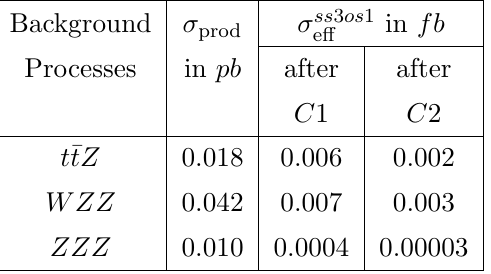
) after the cuts of di(cid:11)erent SM